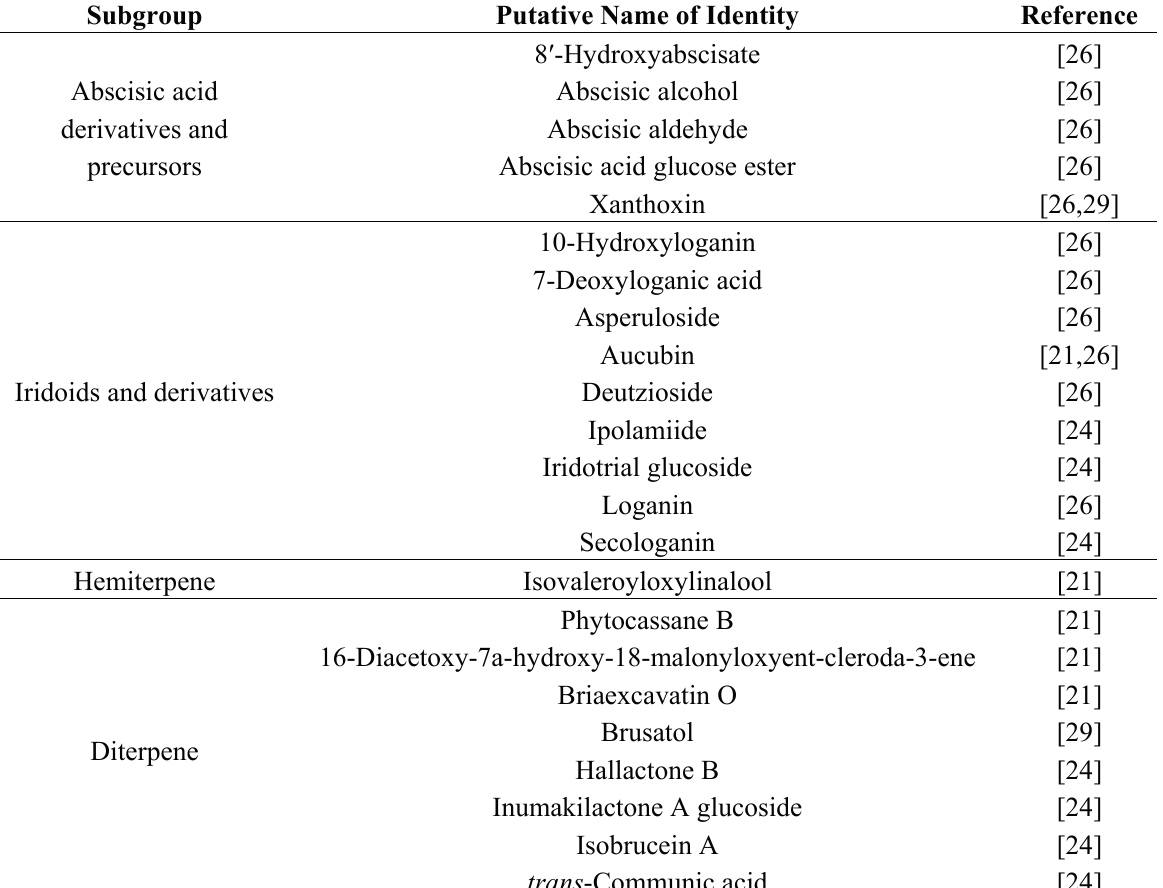
Table 5. Metabolites pinpointed for their potential contribution to FHB resistance and putatively assigned to terpenoid